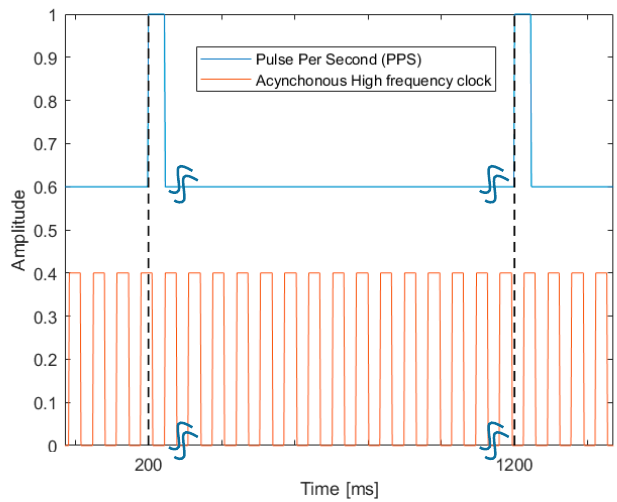
Figure 7. Example of an asynchronous high frequency clock.